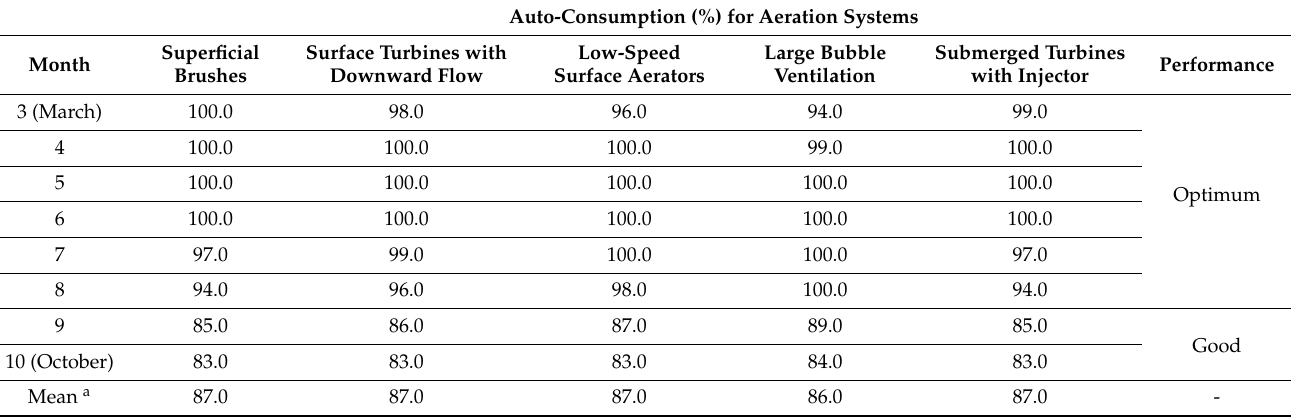
Table 3. Auto-consumption for each aeration system (from March to